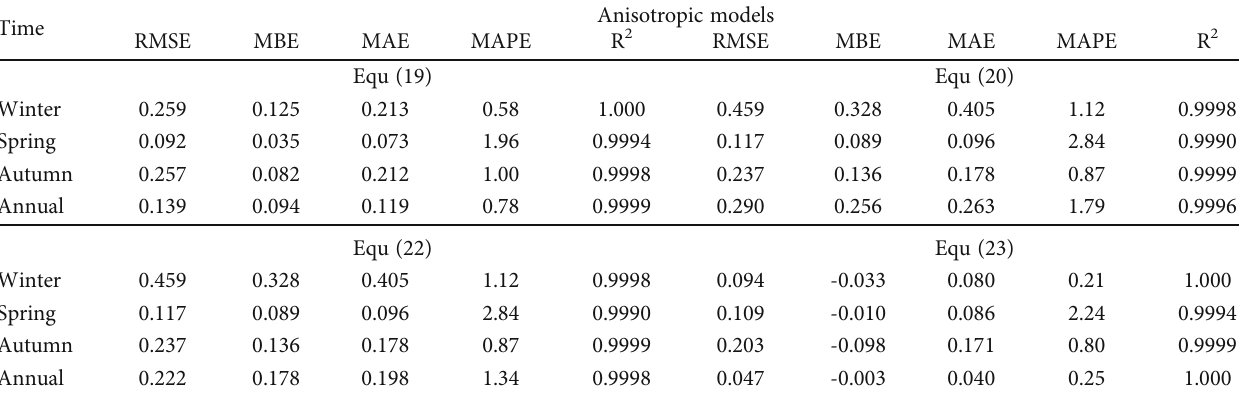
Table 7: Performance evaluation of the anisotropic developed optimal tilt angle model using statistical indices. Time